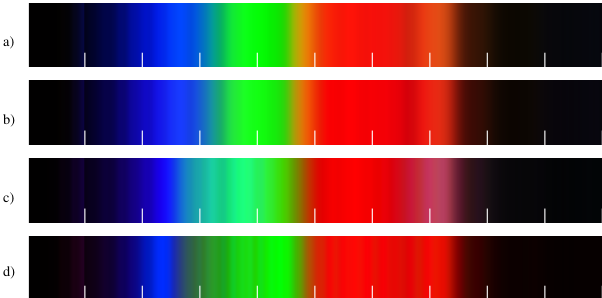
Figure 15. Color bars for calibration wavelengths from 350 to Fig.15. Colorbarsforcalibrationwavelengthsfrom350nmto850nmwithtickmarksat50nmintervals. Top 850nm with tick marks at 50nm intervals. Top bar (a) is direct map- bar (a) is direct mapping of ICX285HQ Bayer matrix to RGB. Lower three are Backus-Gilbert estimation of CIERGBchannelsfor(b)ICX285HQ,(c)ICX429AKLfastmode,and(d)ICX429AKLrawmode. ping of ICX285HQ Bayer matrix to RGB. Lower three are Backus– Gilbert estimation of CIE RGB channels for (b) ICX285HQ, (c) ICX429AKL fast mode, and (d) ICX429AKL raw